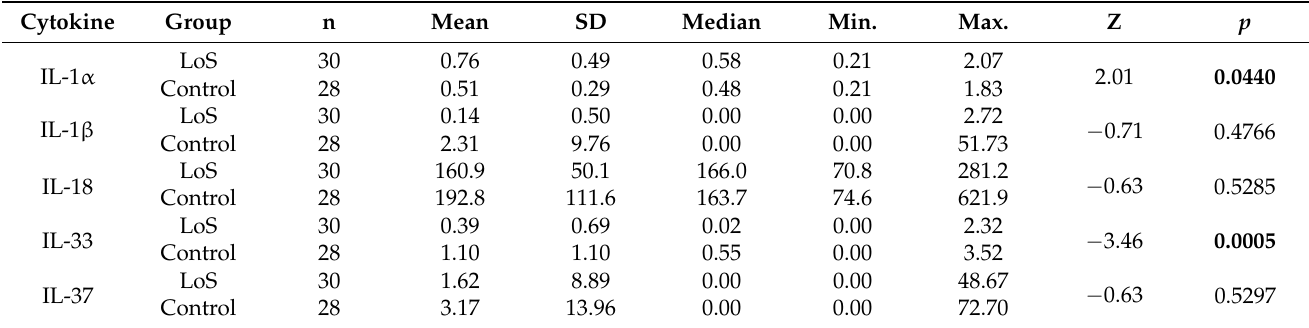
Table 5. Comparison of post-treatment (after systemic and topical or only topical treatment) cytokines concentrations in LoS patients and